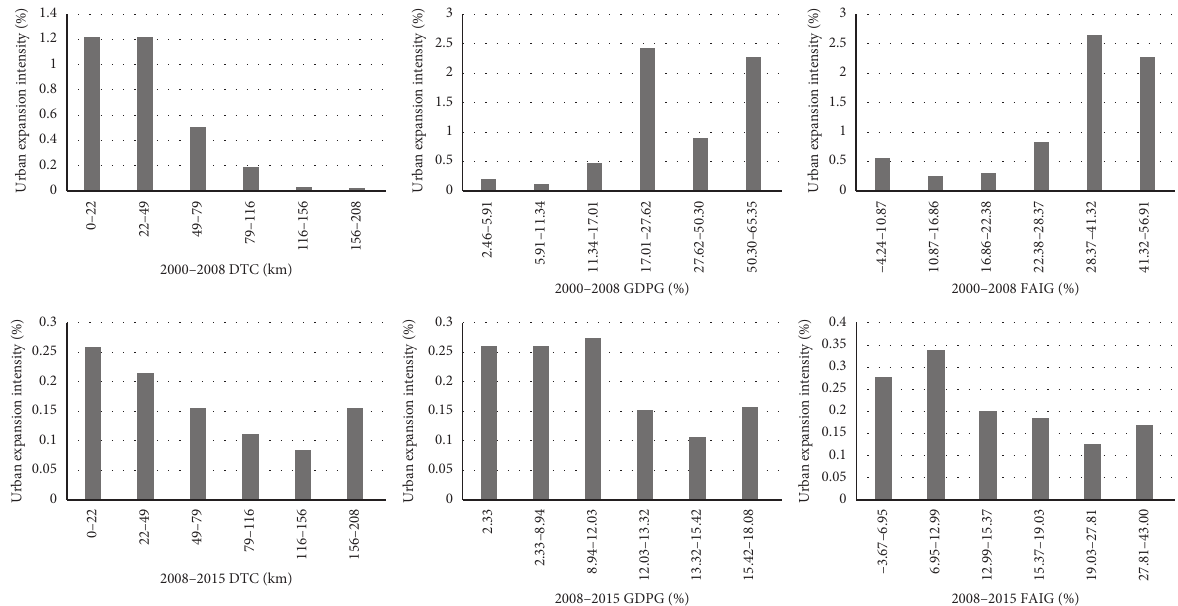
Figure 5: Risk analysis of DTC, GDPG, and FAIG on urban expansion intensity during 2000–2008 and